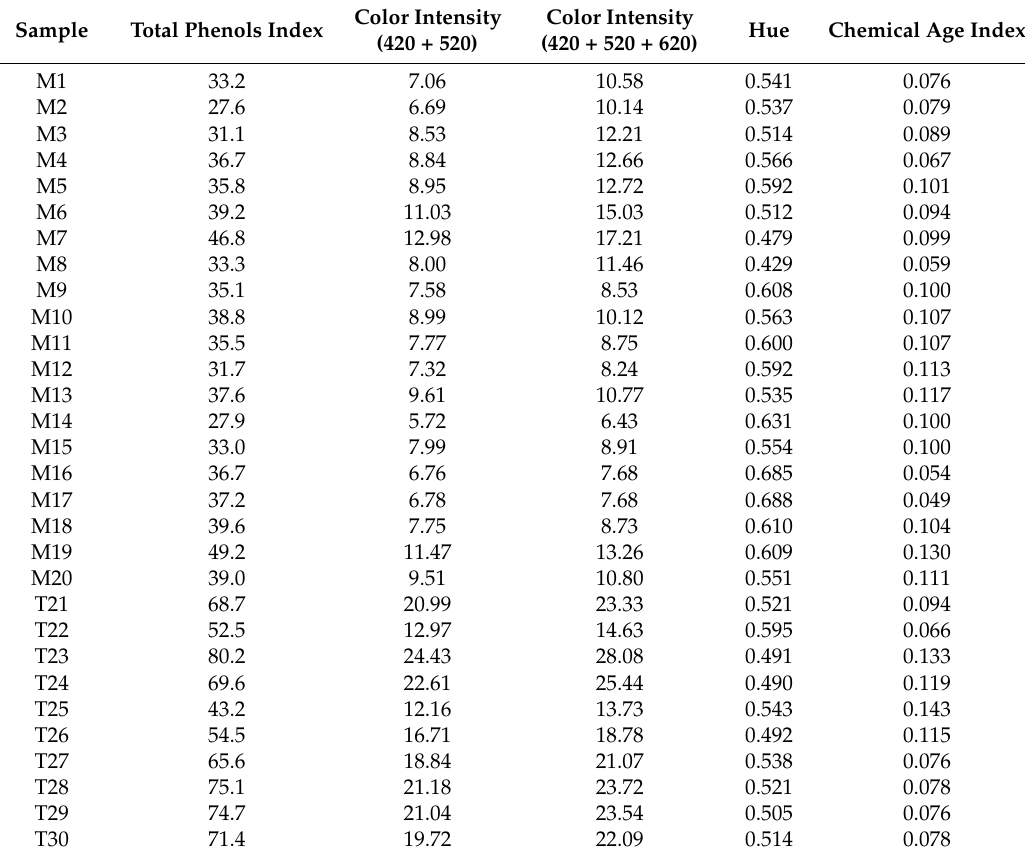
Table 1. Total phenols, color intensity, hue, and chemical age in Mencia (M) and Alicante Bouschet (T) young red wines. Results are mean values of two